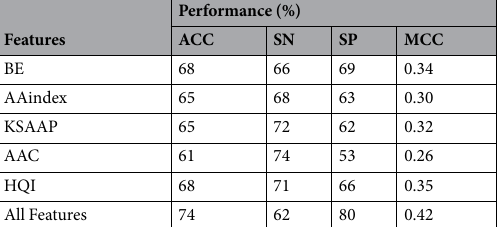
Table 2. Independent test result using individual and cumulative features.